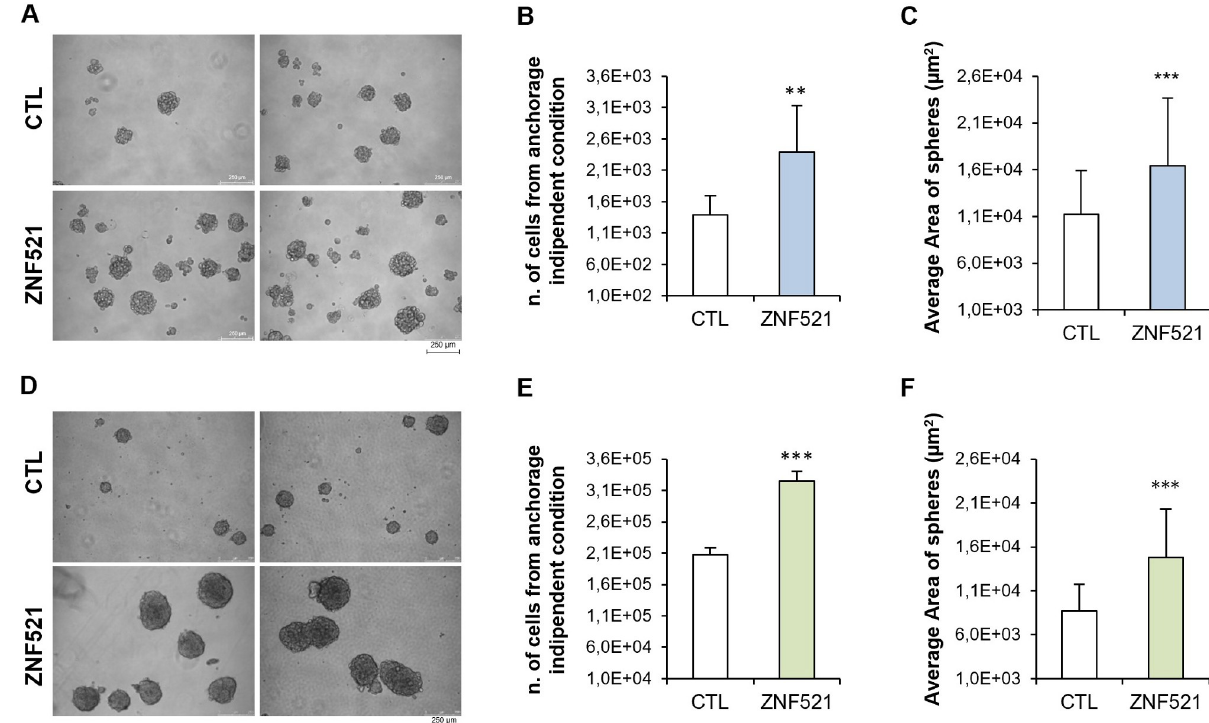
Fig 4. ZNF521 enforced expression enhances spheres-forming ability in HeyA8 and ES-2 cell lines. Representative images (10x) are shown for HeyA8 (A) and in ES-2 (D). Scale bars correspond to 250 μ m. Lentiviral-mediated enforced expression of ZNF521 in ovarian cell lines increases spheres number and size in HeyA8 (B, C) and ES-2 (E, F). Average areas of the 50 spheres are shown. The data shown here illustrate the mean of 3 sets, each conducted in triplicate. Asterisks indicate p < 0,05 � , p < 0,01 �� , p < 0,001 ���